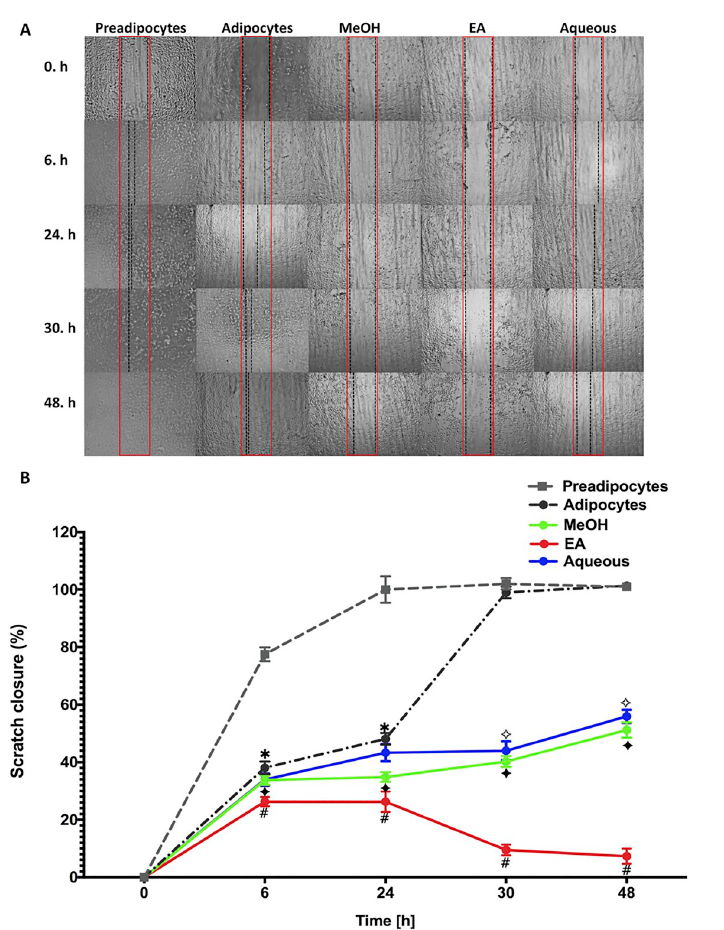
Fig 6. Scratch assay showing the effect of B . spergulifolius extracts on the cell migration ability of 3T3-L1 adipocytes. The cell migration ability was determined by Scratch assay in preadipocytes, mature adipocytes without B . spergulifolius extracts and adipocytes treated with IC 50 dose of MeOH, EA and Aqueous of B . spergulifolius extracts. Cells were cultured to confluent cell monolayers were scratched using the micropipette tip incubated for 0–48 h. A. Representative microscopic images (at 10X magnification) captured at 0. h, 6. h, 24. h, 30. h and 48. h showing in vitro scratch assay wound healing nature of B . spergulifolius extracts. The boundaries of the wounds in cells were presented by the red (initial scratch wound) and black (final scratch wound) colored lines (Scale bar: 100 μ m) B. The scratch closure rate was quantified using ImageJ software. Data are presented as a percentage of the closure of scratch-wound area at time 0. h and the means ± SD from three independent experiments. To analyze statistical was used one- ANOVA tests followed by Tukey’s test were used. � p < 0.05, significantly different from Preadipocytes. ✧ p < 0.05, ✦ p < 0.05, and # p < 0.05, significantly different from mature 3T3-L1